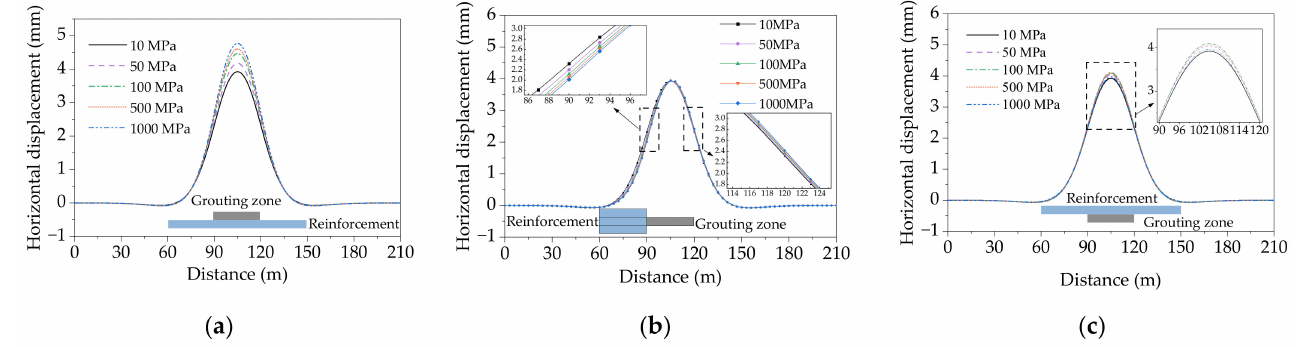
Figure 9. Grouting-induced horizontal tunnel displacement. ( a ) From far to near (Case 1); ( b ) from one side to the other (Case 2); ( c ) from near to far (Case 3).